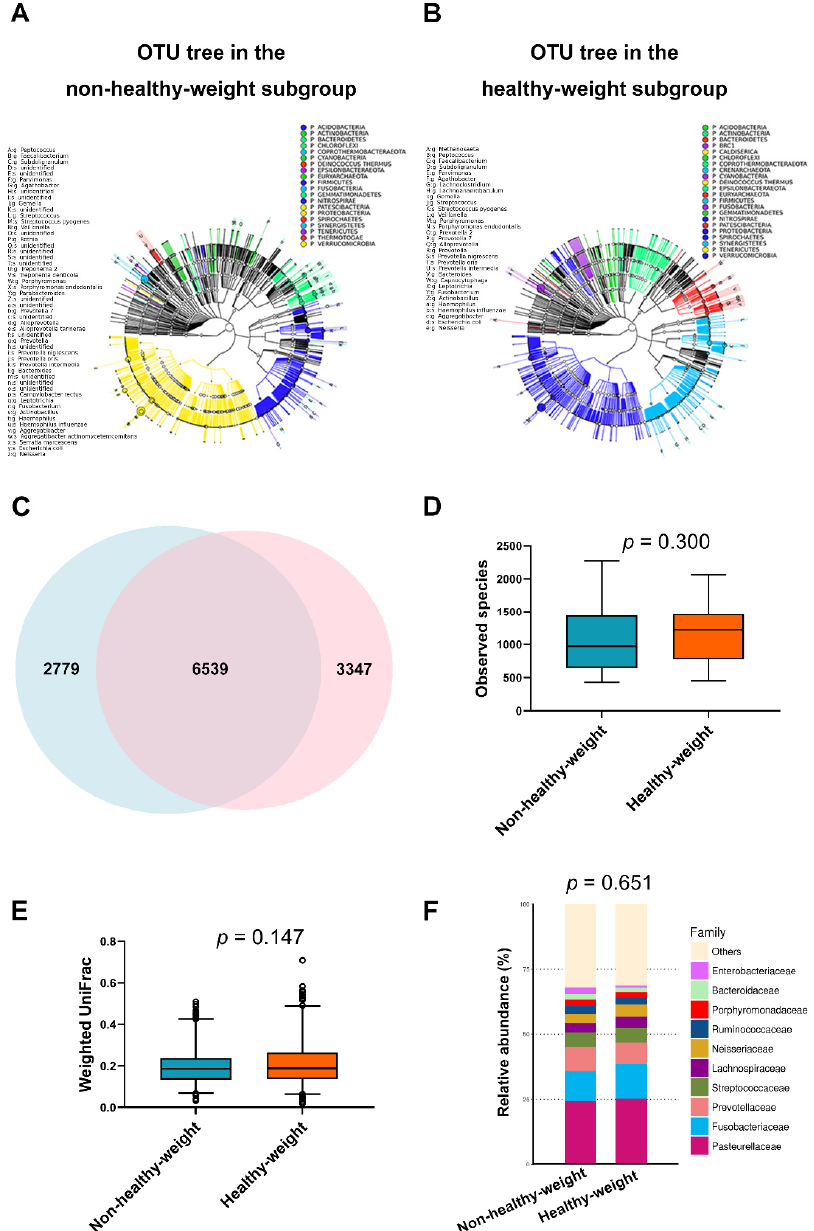
Figure 2. Tonsil microbiome in children with obstructive sleep apnea. ( A ) The operational taxonomic unit (OTU) tree of the non-healthy-weight subgroup ( n = 33) included 9318 OTUs, assessed by Graphical Phylogenetic Analysis. ( B ) The OTU tree of the healthy-weight subgroup ( n = 33) included 9886 OTUs. ( C ) A Venn diagram demonstrated that both subgroups shared 6539 OTUs; otherwise, the non-healthy-weight subgroup had 2779 deferential OTUs and the healthy-weight subgroup had 3347 deferential OTUs. ( D ) The α diversities of both subgroups were equal ( p = 0.300; Mann–Whitney U test). ( E ) Furthermore, the β diversity of the non-healthy-weight subgroup was comparable to that of the healthy-weight group ( p = 0.147; Mann–Whitney U test). ( F ) The relative abundances of the top 10 tonsil families in the non-healthy-weight subgroup were similar to those in the healthy-weight subgroup ( p = 0.651; analysis of similarity test).